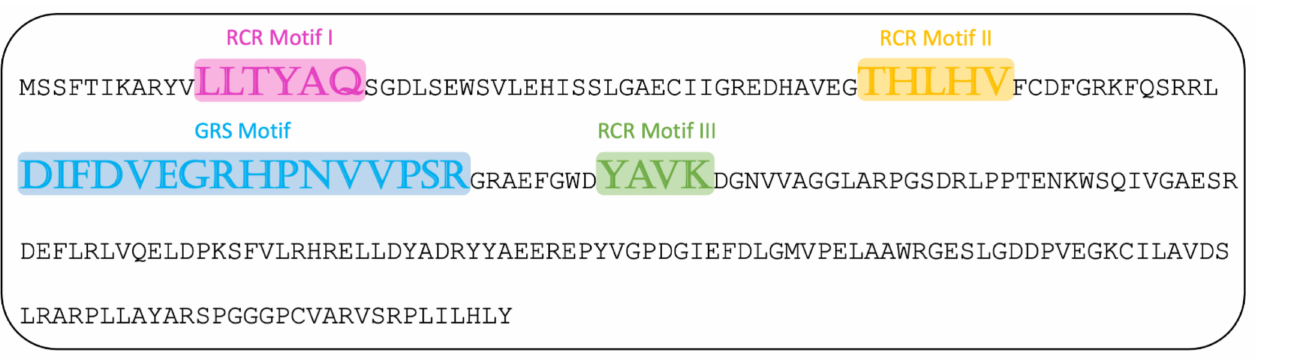
Figure 6. Conserved motifs in the Rep of the Gemycircularvirus found in this study in accordance with data by Varsani et al.